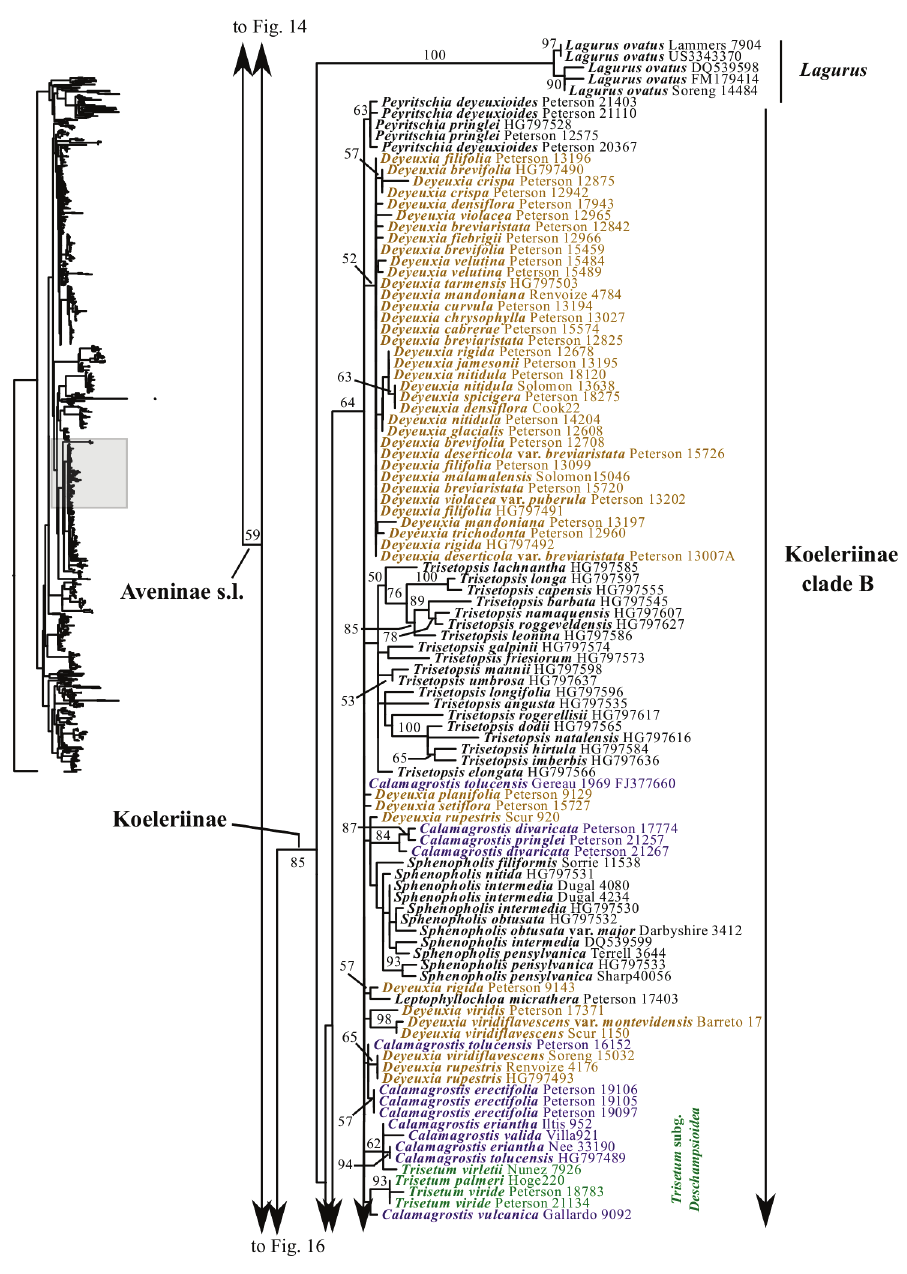
Figure 15. A portion ( Lagurus , Koeleriinae clade B) of the maximum likelihood phylogram inferred from ITS data. ML bootstrap support is recorded along branches when >50%. The shaded area of the smaller tree on the left indicates the location in the overall tree of the portion